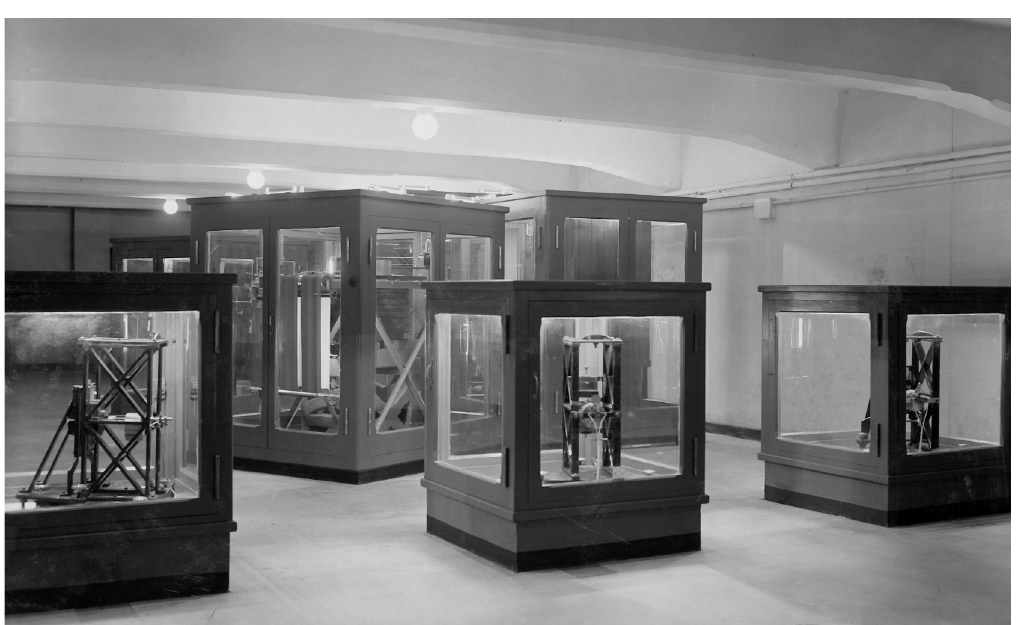
Fig. 2. Galitzin seismographs installed at Roma seismic station